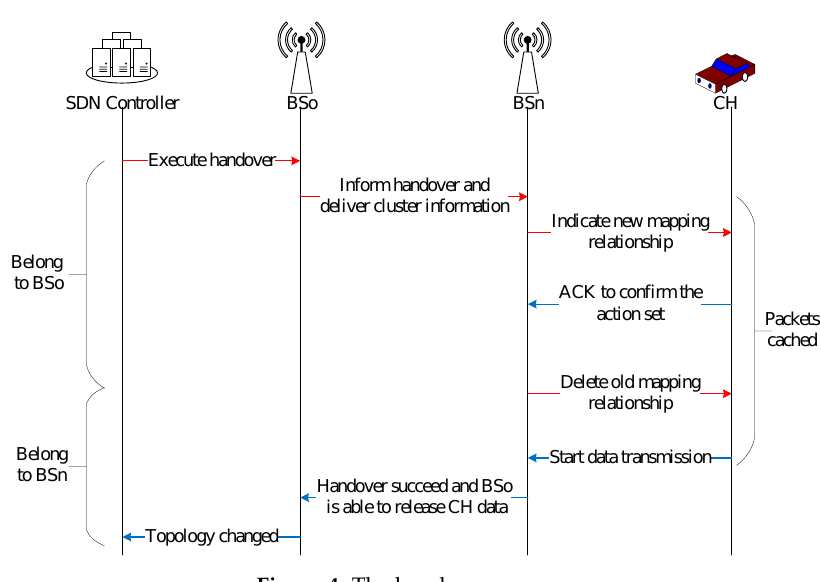
Figure 4. The handover